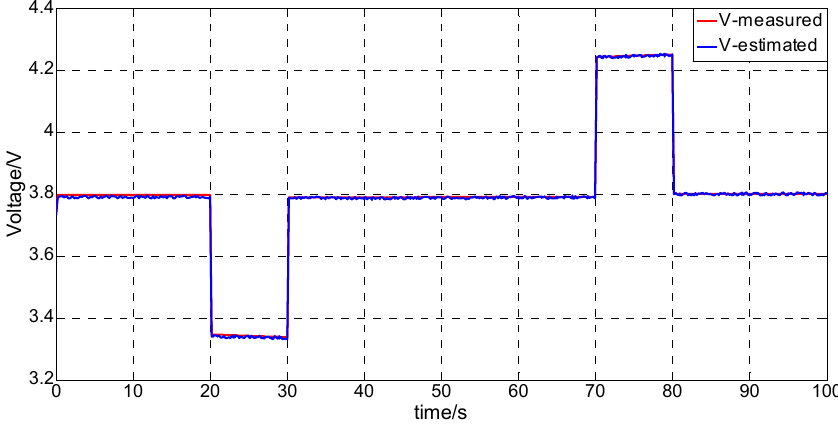
Figure 7. Comparison of voltage responses.